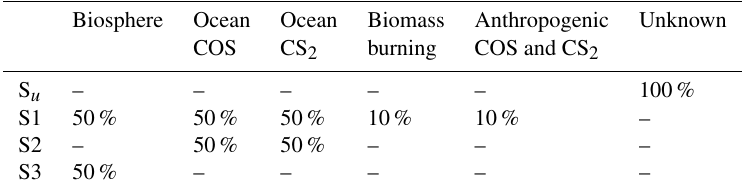
Table 3. Names and error settings of the inversions performed in this study. The values correspond to grid-scale errors. Monthly flux fields are optimized using spatial and temporal correlation lengths of 4000km and 12 months, except for inversion S u , in which multiple settings are explored. Biosphere Ocean